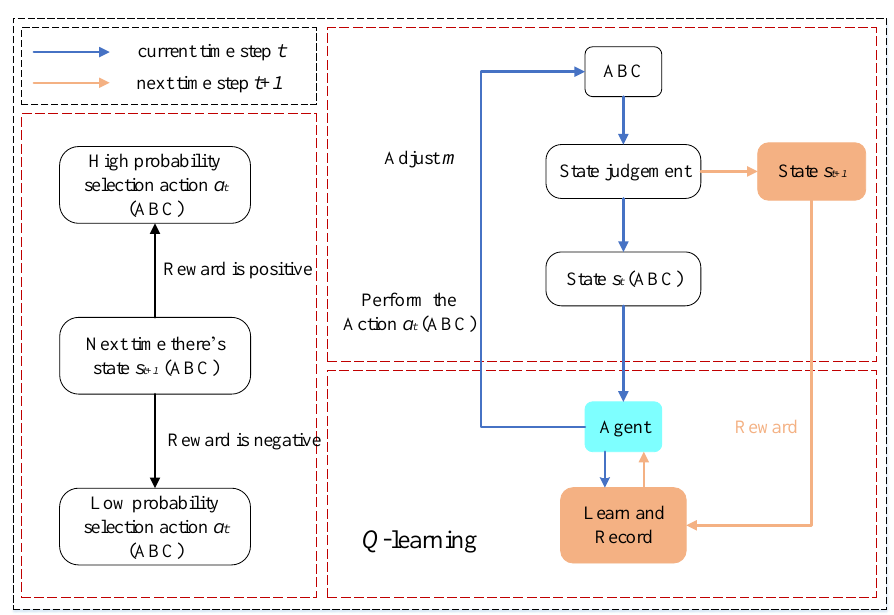
Figure 8. Schematic diagram of SLABC